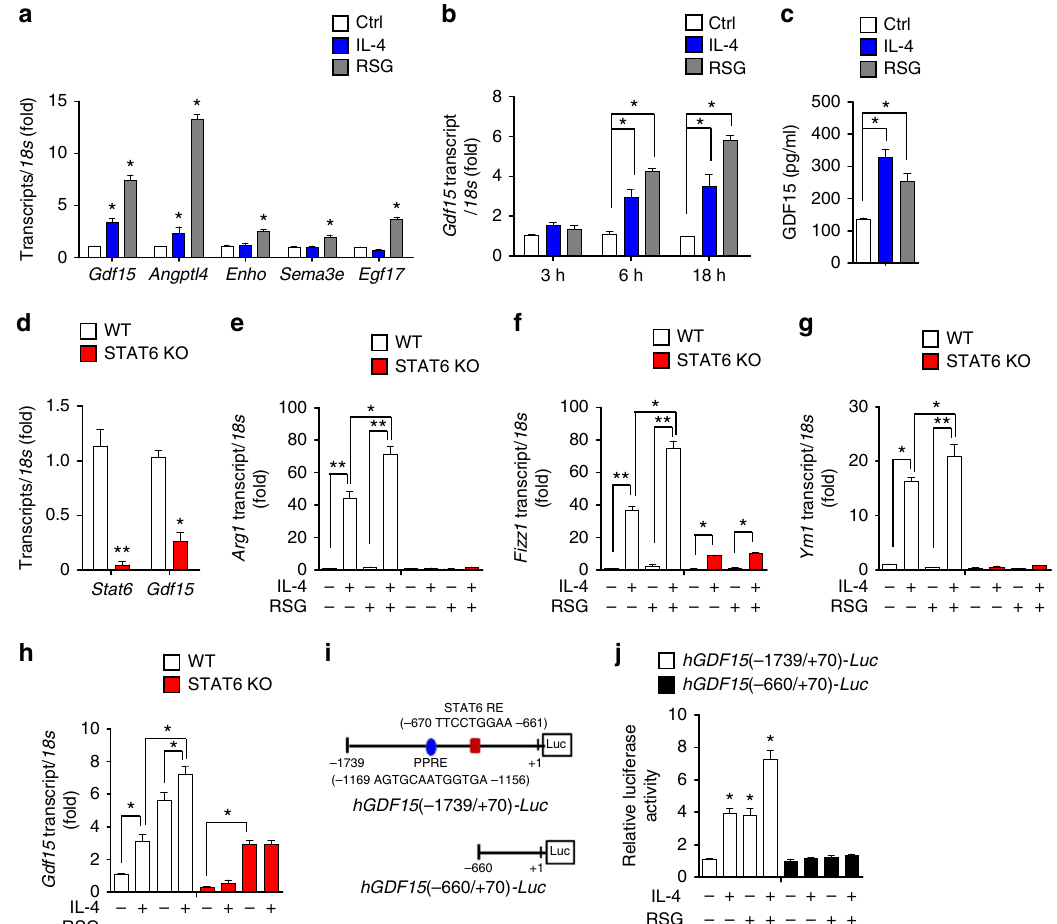
Fig. 3 PPAR γ agonist and STAT6 modulate GDF15 expression. a Real-time PCR analysis of Gdf15 , Angptl4 , Enho , Sema3e , and Egf17 mRNA expression in BMDMs 18 h after treatment with rosiglitazone (RSG) (10 μ M) and IL-4 (100 ng/ml). b Real-time PCR analysis of Gdf15 mRNA in BMDMs 3, 6, and 18 h after treatment with rosiglitazone (10 μ M) and IL-4 (100 ng/ml). c GDF15 levels in culture supernatants from BMDMs treated with rosiglitazone (10 μ M) and IL-4 (100 ng/ml) for 48 h. d Real-time PCR analysis of Stat6 and Gdf15 mRNA expression in BMDMs from WT and Stat6 -KO mice. e – h Real-time PCR analysis of Arg1 , Fizz1 , Ym1 , and Gdf15 mRNA expression in BMDMs after 18 h treatment with rosiglitazone (10 μ M) and IL-4 (100 ng/ml) from WT and Stat6- KO mice. i Schematic structure of reporter constructs containing a 1739 or 660 bp fragment of the human GDF15 promoter. j Relative luciferase activity induced by the human GDF15 promoter in RAW264.7 cells transfected with hGDF15(-1739/ + 70)-Luc or hGDF15(-660/ + 70)-Luc and cultured with or without rosiglitazone (10 μ M) and IL-4 (100 ng/ml) for 24 h. Data are expressed as means ± SEM and are representative of three independent experiments. * p < 0.05 or ** p < 0.01 (two-tailed Student ’ s t